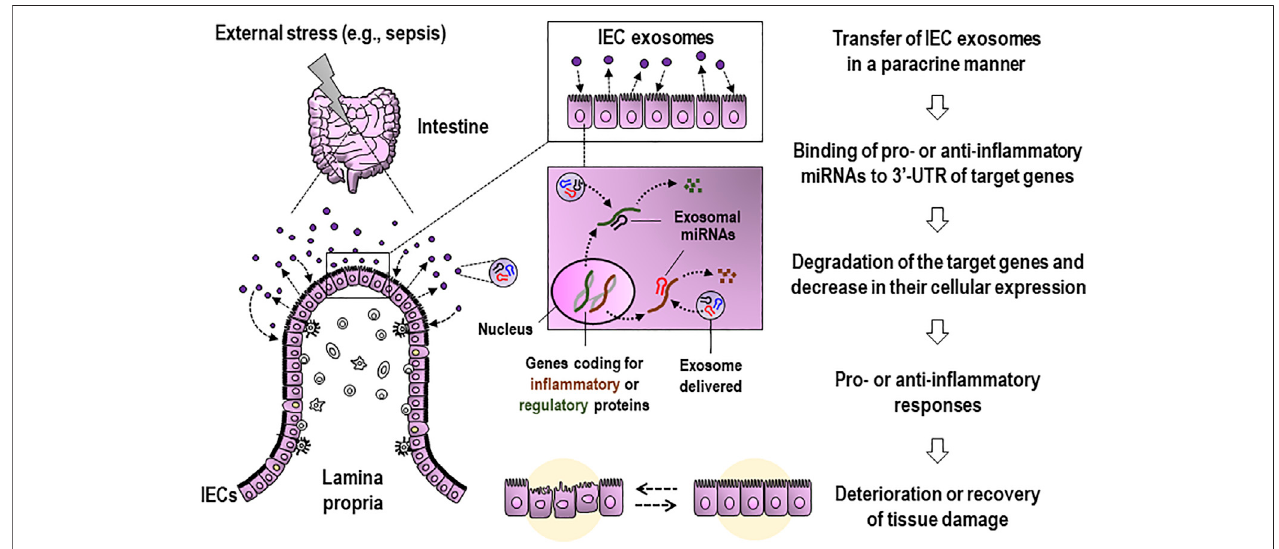
FIGURE1| ProposedmodelfortheroleofapicallyreleasedIECexosomesduringexternalstress,suchassepsis,inaffectingtissuedamageandgutin fl ammation. LuminallysecretedIECexosomesreachneighboringcellsinaparacrinemannerandtransferfunctionalmiRNAstothecells.Then,theIEC-derivedmiRNAsareexpected to be capable of suppressing the gene expression of pro- or anti-in fl ammatory mediators and proteins at post-transcriptional levels and consequently alleviating or aggravating in fl ammation-associated intestinal injury and barrier dysfunction. IEC, intestinal epithelial cell; 3 ′ -UTR, 3 ′ -untranslated